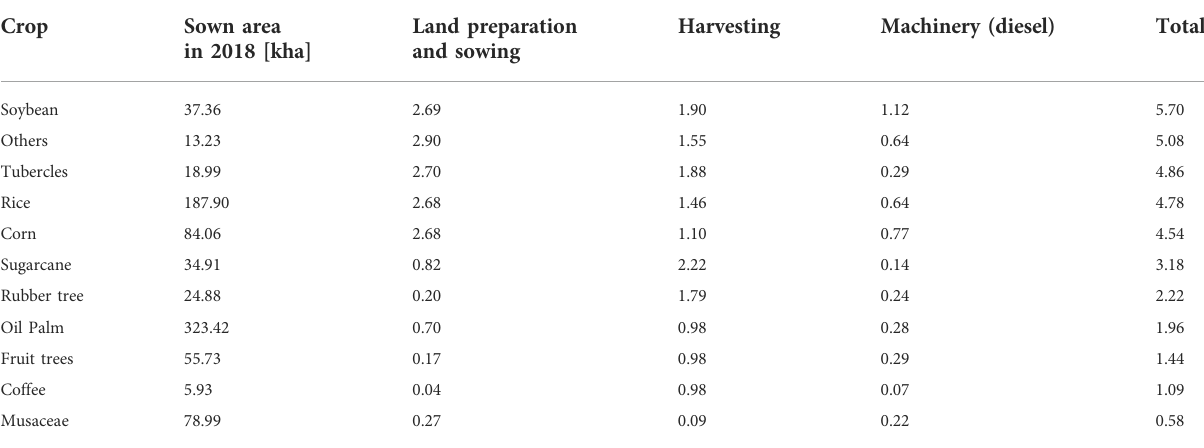
TABLE 1 Crop production emission factors disaggregated by activity and crop